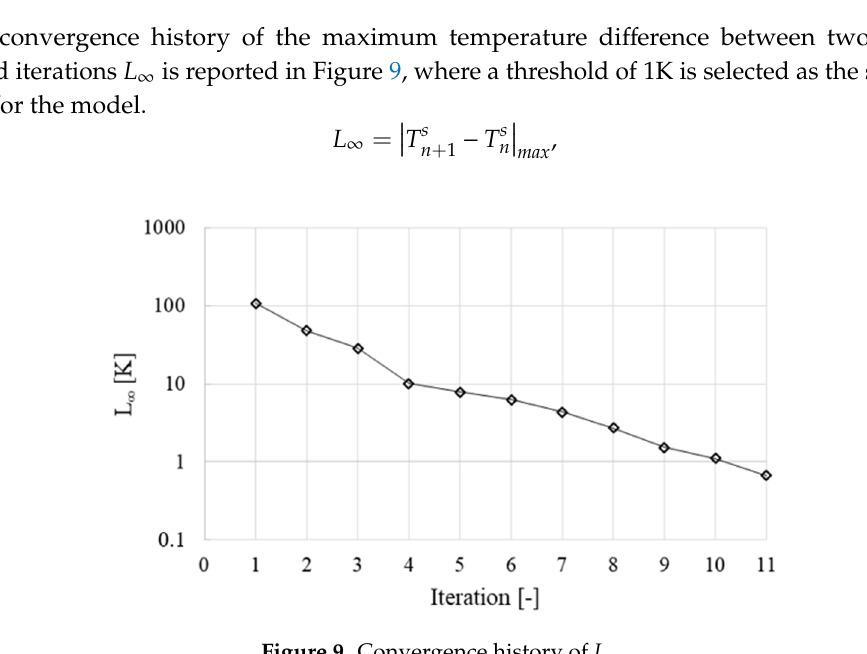
Figure 10. CHT problem for flat plate: ( a ) temperature at the domain interface, ( b ) temperature profile at x = 0.05 m. Numerical vs. analytic solution. 4.2. Rotor Mesh Sensitivity Analysis A mesh sensitivity study for the CHT analysis is performed on a three-dimensional test case presented in [19], considering a radial turbine impeller with 10 blades and an inlet diameter of 50 mm. A two-dimensional sketch of the domain on the meridional plane of the rotor is reported in Figure 11, along with the locations of the imposed boundary conditions. The method of the characteristics [56] is adopted to establish the number of physical conditions to be assigned at the inflow and outflow boundaries. The total upstream temperature and pressure are specified at the inlet of the domain, along with flow velocity components in the corresponding coordinate system.